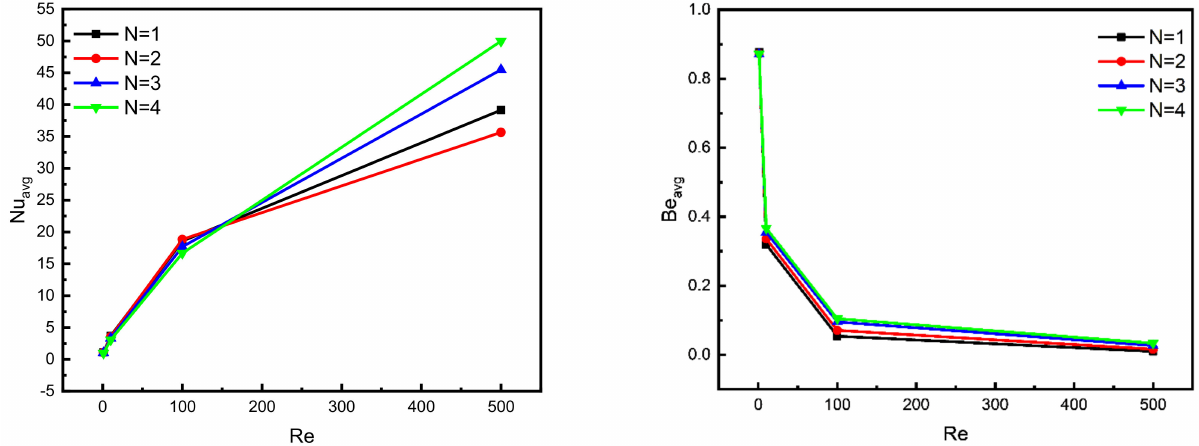
Figure 8. Effect of N on Nu avg and Be avg for ϕ = 0.04, Ha = 0, and Da = 10 − 2